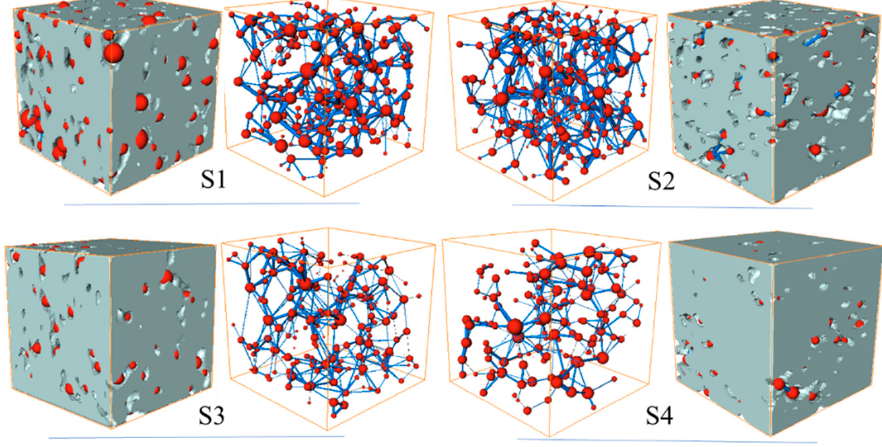
Figure 9. Characterization of PNM evolution in shear process: The PNMs corresponding to samples S1, S2, S3 and S4 respectively in the figure. Table 3. Statistical table of hole throat size data.